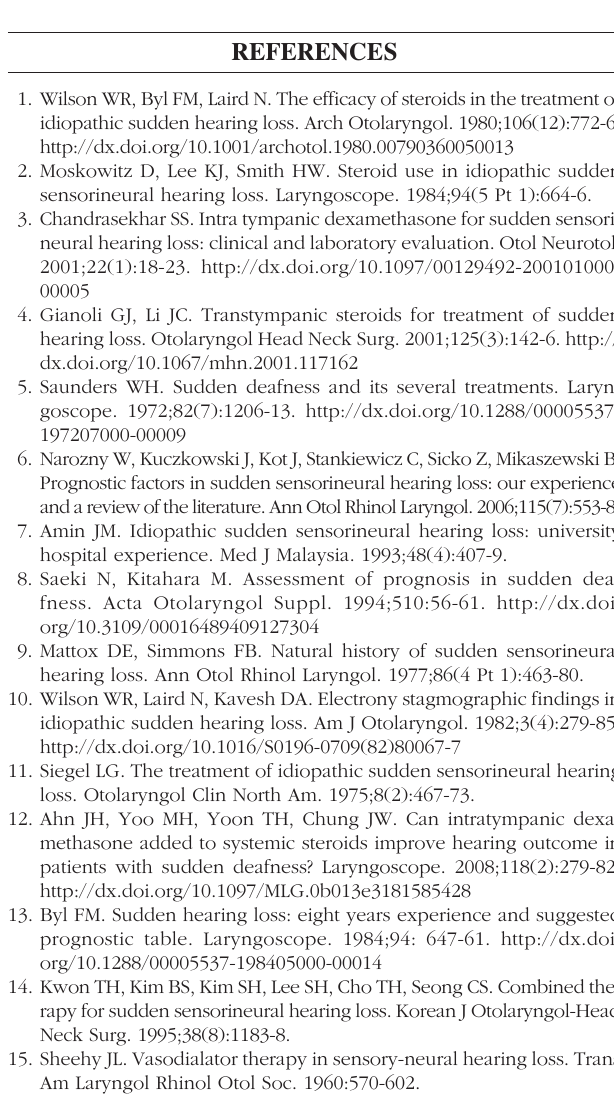
Table 4. Analysis of interaction effects between vertigo and treatment onset, initial hearing level. Models